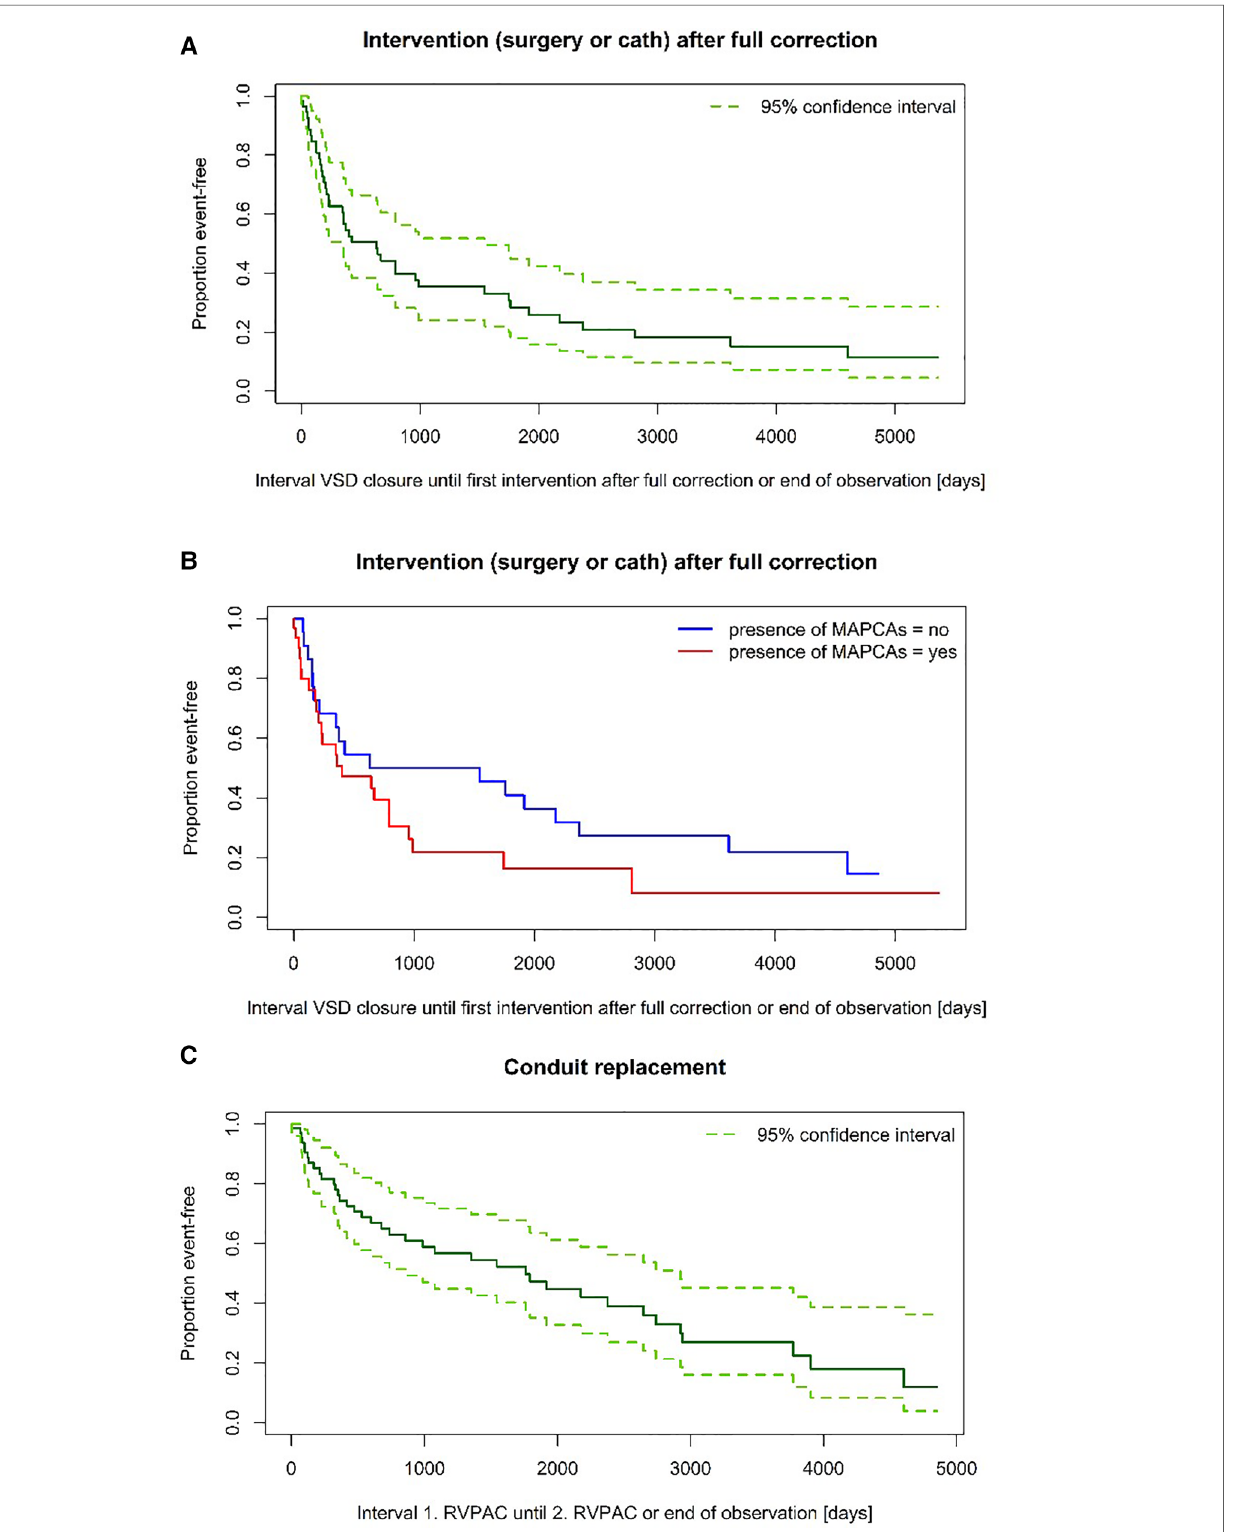
FIGURE 3 ( A ) Time to intervention after VSD closure. ( B ) Time to intervention after VSD closure — subgroup comparison (log-rank test: p =0,149). ( C ) Time to RVPAC replacement.